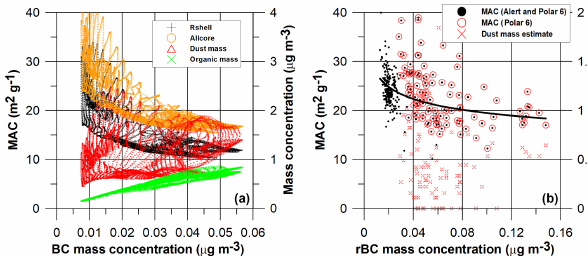
Figure 8. (a) Modelled BC mass absorption coefficient (MAC) plot- ted against modelled BC for the Allcore (orange circles) and the Rshell (black crosses) assumptions; modelled dust mass concentra- tions constrained to dust less than 1.5µgm − 3 vs. modelled BC mass concentrations (red triangles); and modelled organic aerosol (OA) mass concentrations vs. BC mass concentrations (green crosses). All modelled values are for 1–14 April 2015. (b) MAC values from Polar 6 flights and Alert observatory (1–14 April) plotted against measured refractory black carbon (rBC) mass concentrations (black dots); dust mass concentrations (red crosses) estimated from parti- cle size distributions onboard the Polar 6 plotted against rBC mass concentrations; and MAC values associated with Polar 6 measure- ments only are identified (red circles). In (b) , the black line is a power law fit to the black points. Power law fits were chosen since, based on the linear fit between absorption and rBC (Fig. 5), the ex- pectation is that MAC will vary inversely with the BC mass concen- tration. The confidence level in the negative slopes is greater than